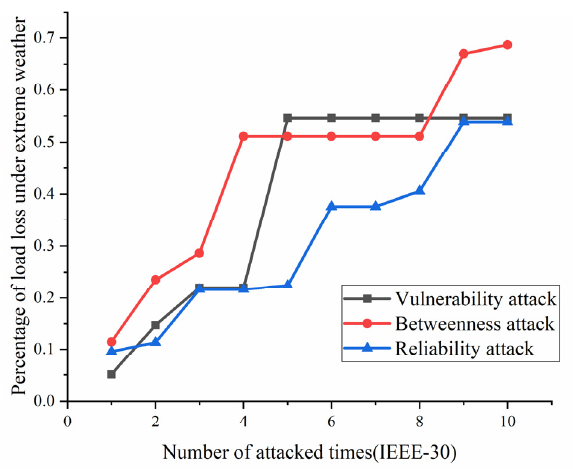
Figure 21. Load loss ratio of IEEE-30 bus system under extreme weather.